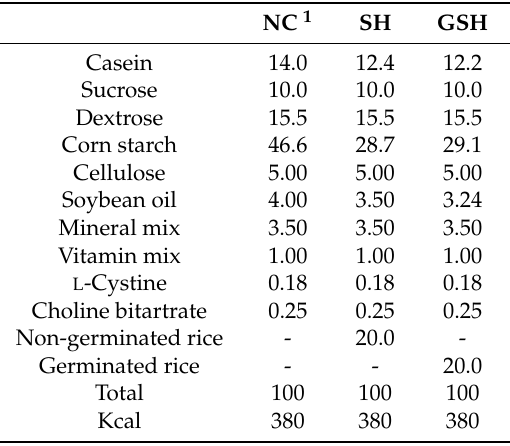
Table 2. Composition of experimental diets